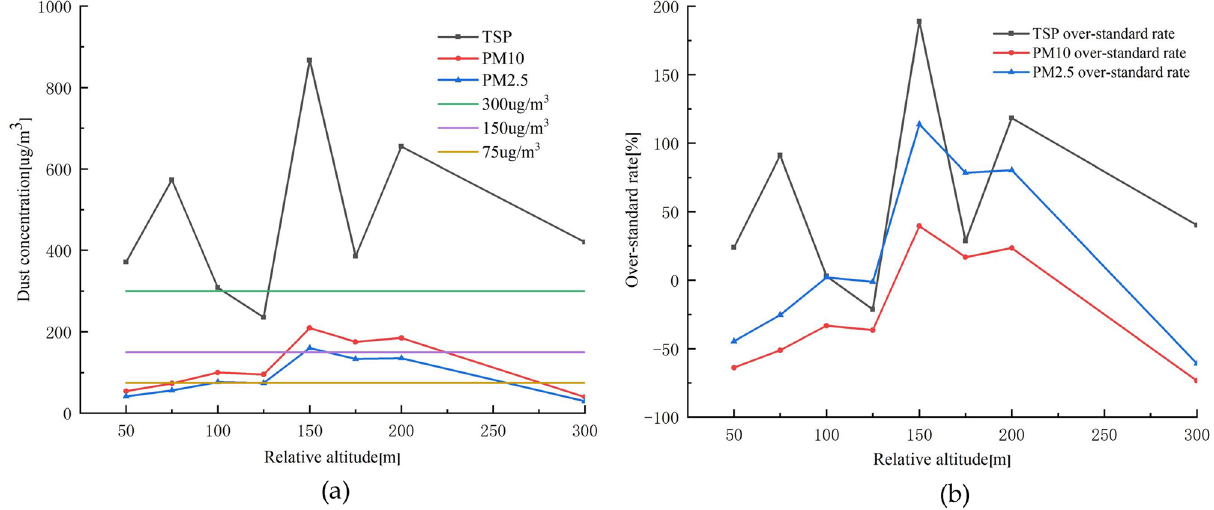
Figure 13. Variation pattern of dust concentration and occupancy rate in winter; ( a ) Dust concentration variation pattern; ( b ) Occupancy rate variation pattern.